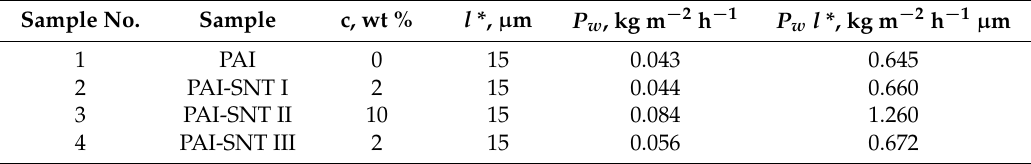
Table 2. Permeate flux for water, P w , and flux normalized to thickness for non-porous composite films in comparison with a nonporous PAI film (sample No. 1) in pervaporation at 40 °C [112]. Sample No.